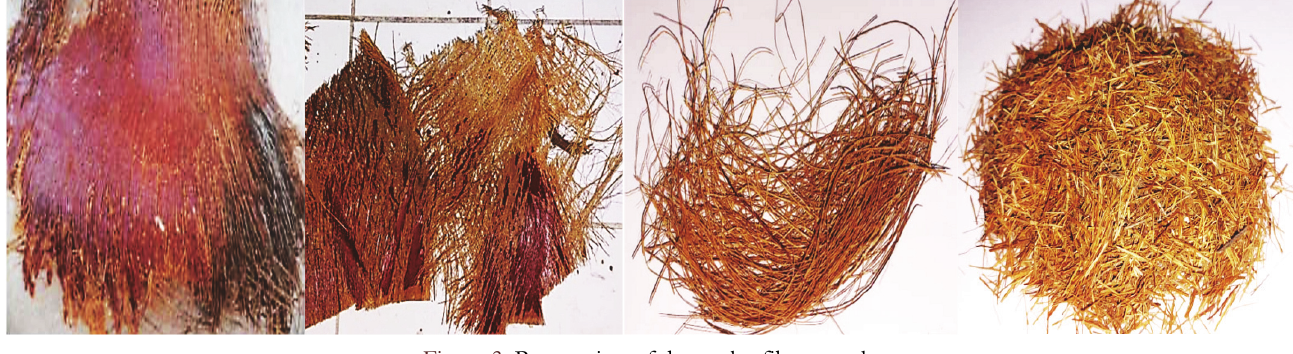
Figure 3: Preparation of date palm fibers mesh.